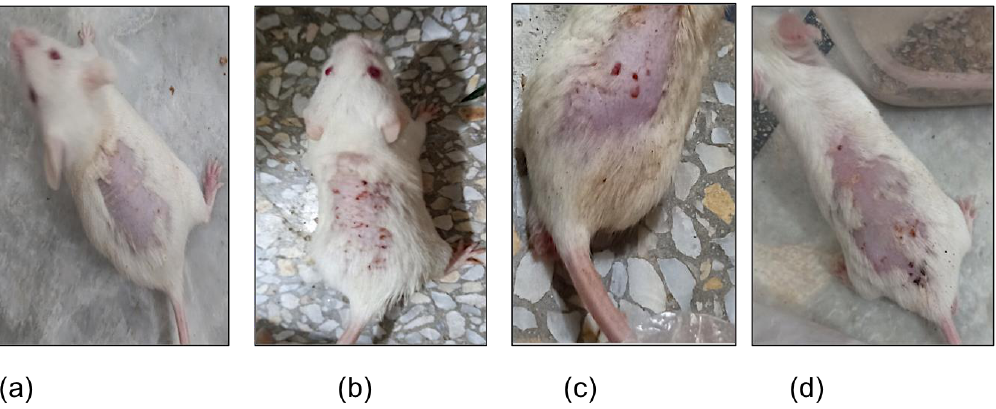
Figure 9. Testosterone-induced acne model in ( a ) normal group, ( b ) negative group, ( c ) positive group, and ( d ) treatment group after 3 weeks